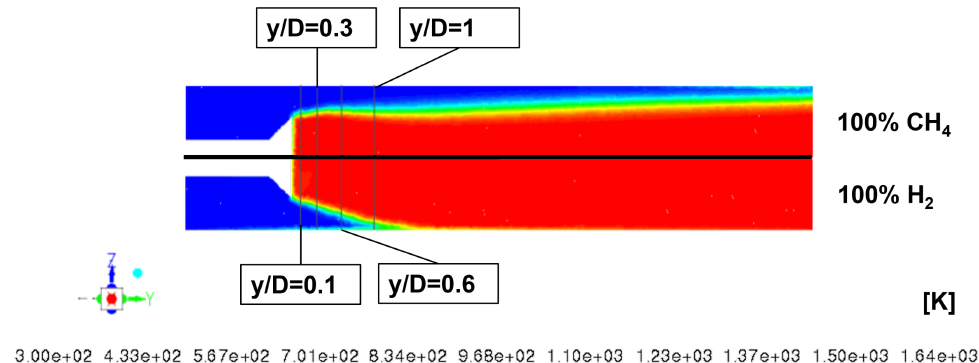
Figure 12. Comparison between the axial velocity contours for the two different mixtures. Transversal lines represent the cross-sections in which the temperature, velocity, and density profiles were measured and compared.